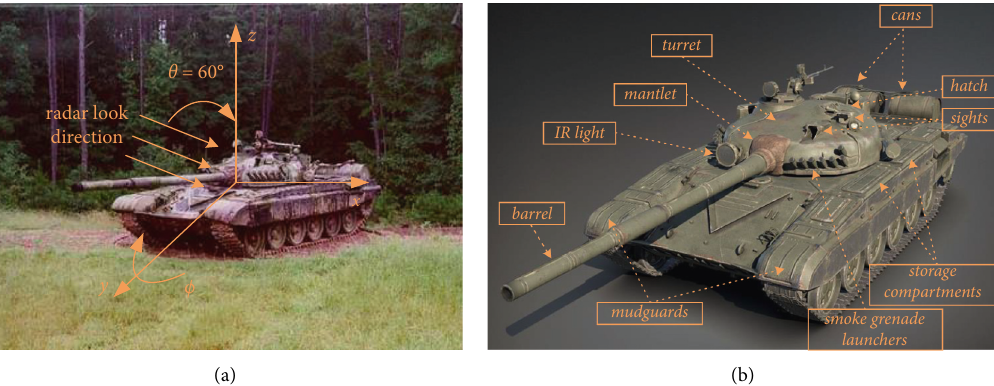
Figure 3: T-72 tank. (a) Real target used in the experiment. (b) Highly accurate CAD model with names of some predominant target parts (photo by courtesy of Serhii Ryzhkov).